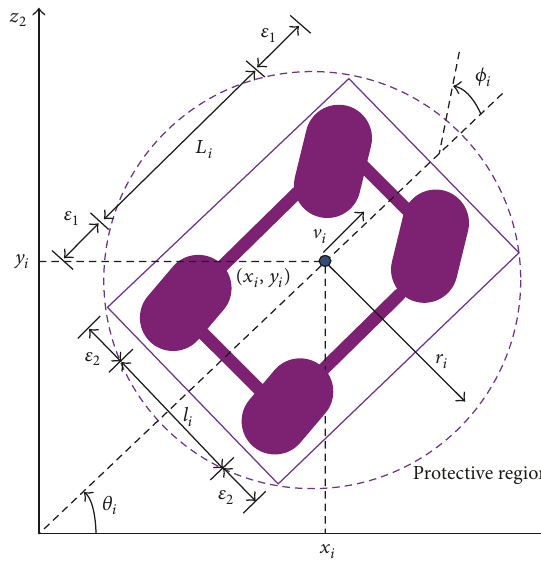
Figure 1: Kinematic model of the car-like mobile